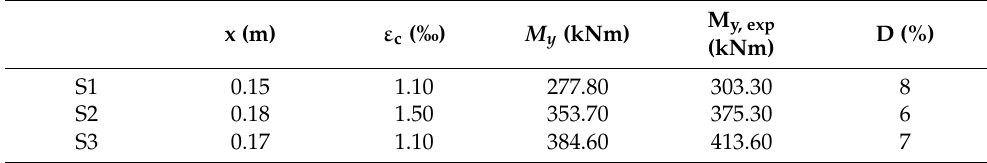
Table 3. Estimated and experimental yield bending